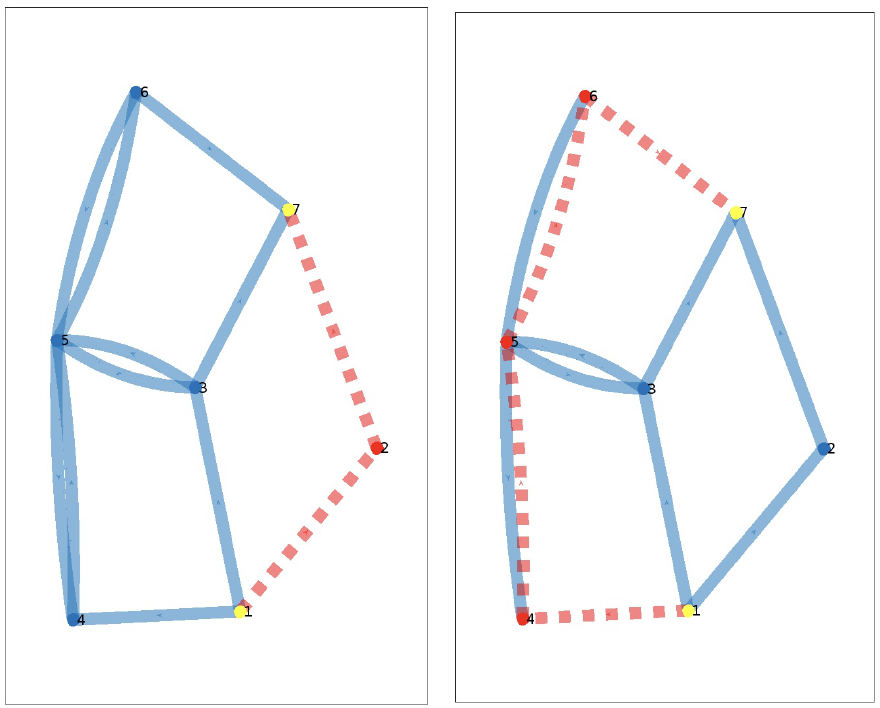
Figure 4. ( Left ): the optimal path (in red) corresponding to Case 2. ( Right ): the alternative optimal path through the sequence of nodes